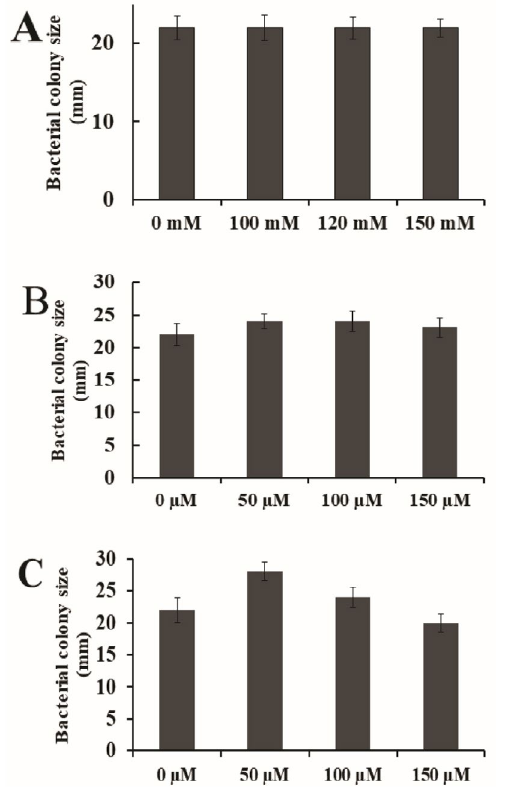
(B), and ZnSO (C) on 4 4